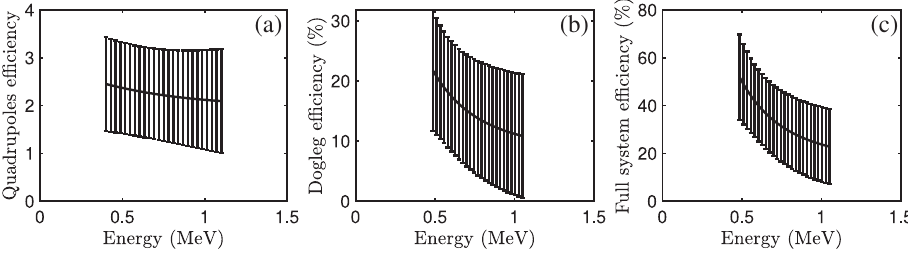
FIG. 4. (a) Ratio between the positron with (blue dashed line in Fig. 3) and without (black solid line in Fig. 3) the Hallbach magnets. (b) Ratio between the positron spectrum with (red dotted line in Fig. 3) and without (blue dashed line in Fig. 3) the second dipole magnet in the dogleg. (c) Ratio between the positron spectrum after the whole system (red dotted line in Fig. 3) and the positron spectrum recorded without second dipole or Hallbach magnets (black solid line in Fig. 3) Error bars originate from the propagation of uncertainties shown in Fig.